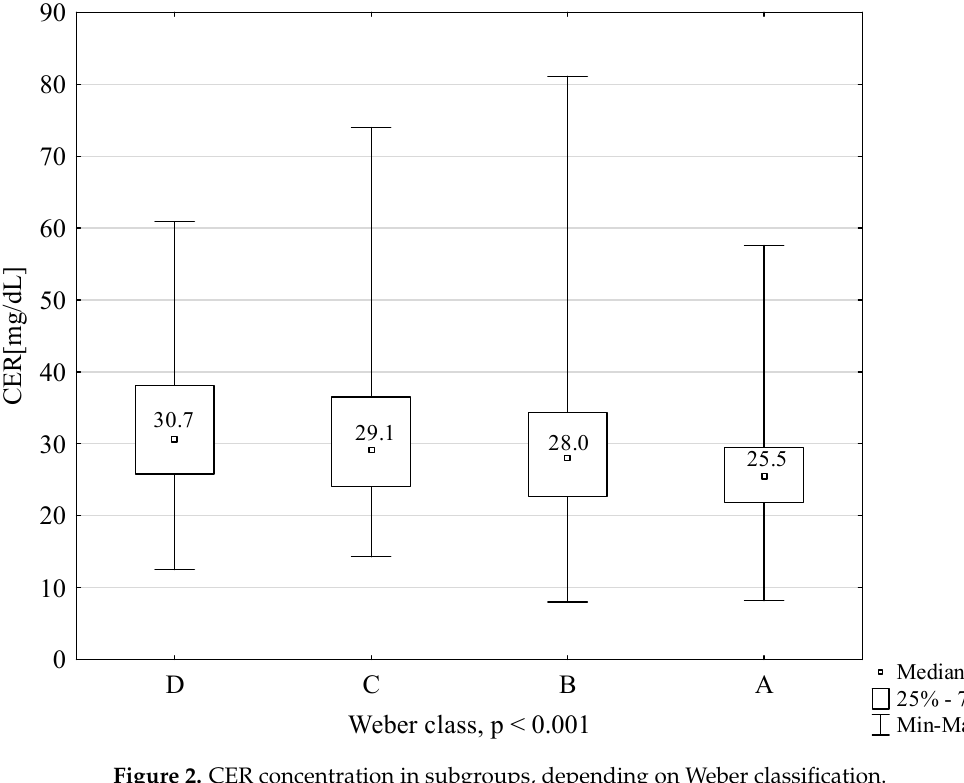
Figure 2. CER concentration in subgroups, depending on Weber classification.